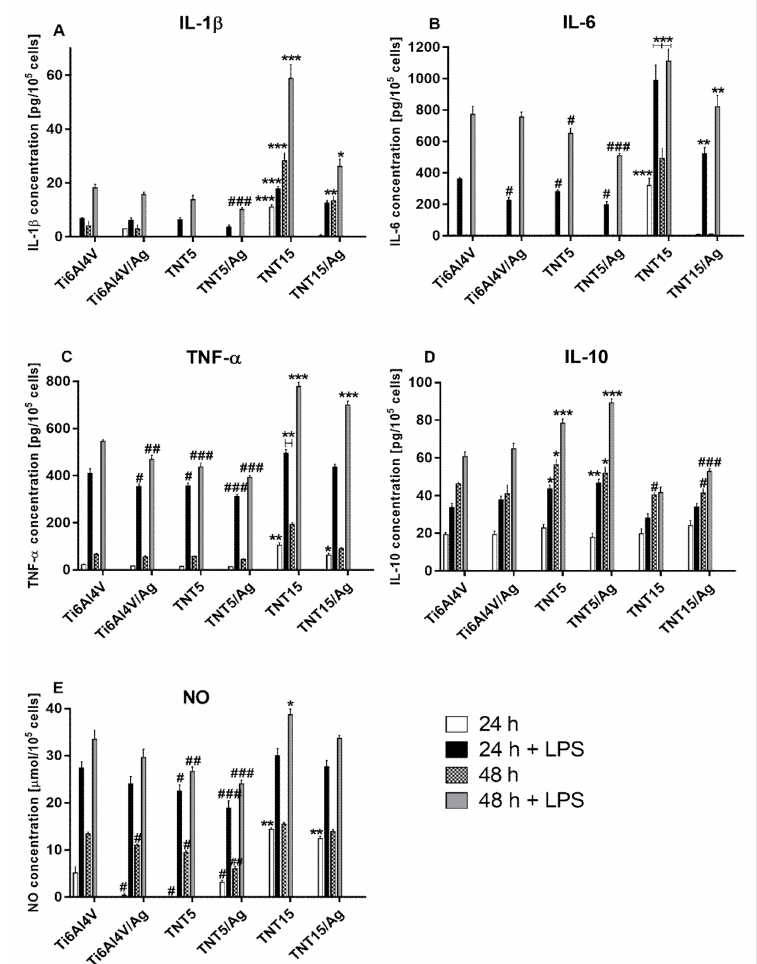
Figure 5. Secretion of pro-inflammatory ( A – C ) and anti-inflammatory ( D ) cytokines or total nitric oxide ( E ) by RAW 264.7 macrophages in the standard and LPS-stimulated conditions. The cells were cultured on the tested specimens for 24 and 48 h. Cytokine and nitric oxide (NO) production was normalized to a number of 105 cells. Data are expressed as mean ± SE ( n = 3). Asterisks indicate significant di ff erences at the appropriate incubation time when the amounts of cytokines and NO produced by the cells growing on the tested specimens were higher in comparison with the reference Ti6Al4V alloy foils (Ti6Al4V) (*** p < 0.001, ** p < 0.01, * p < 0.05). Hash marks denote significant di ff erences at the appropriate incubation time when the levels of cytokines and NO secreted by the cells cultivated on the tested samples were lower in comparison with the reference Ti6Al4V alloy foils (### p < 0.001, ## p < 0.01, # p <